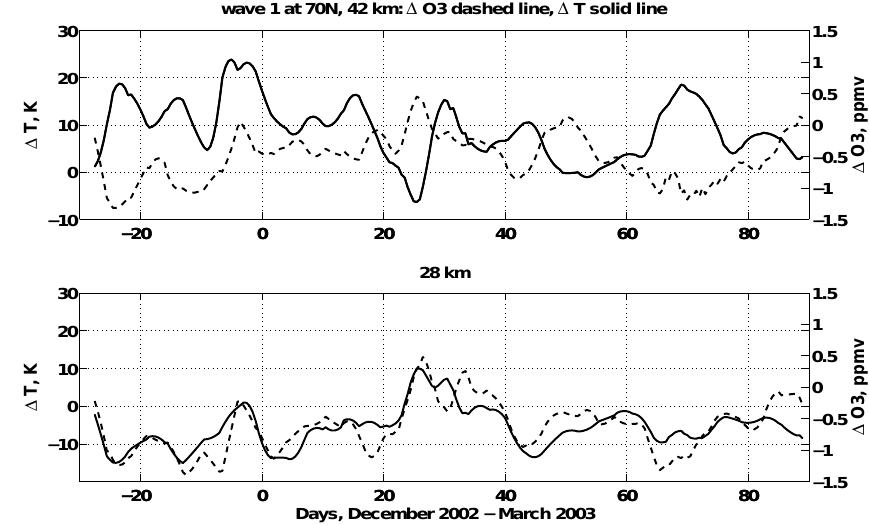
Fig. 6. Wavenumber one perturbation in temperature (left scale, K, solid line) and ozone (right scale, ppmv, dashed line) at 70 ◦ N; upper panel is for the 42km level, lower panel is for the 28km level.